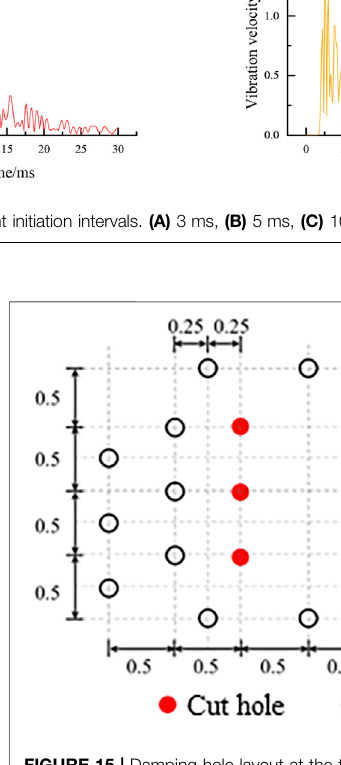
FIGURE 15 | Damping hole layout at the tunnel face (unit: